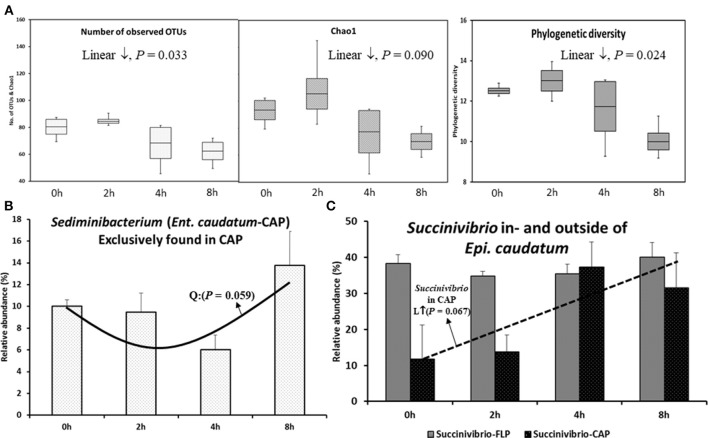
Temporal changes in species richness, phylogenetic diversity, and relative abundance of select taxa after feeding. (A) α-diversity measurements in the CAP of Ent. caudatum. (B)
Sediminibacterium in the CAP of Ent. caudatum, and (C)
Succinivibrio found in- and outside of Epi. caudatum cells. No significant temporal changes of α-diversity measurements were found in Epi. caudatum.